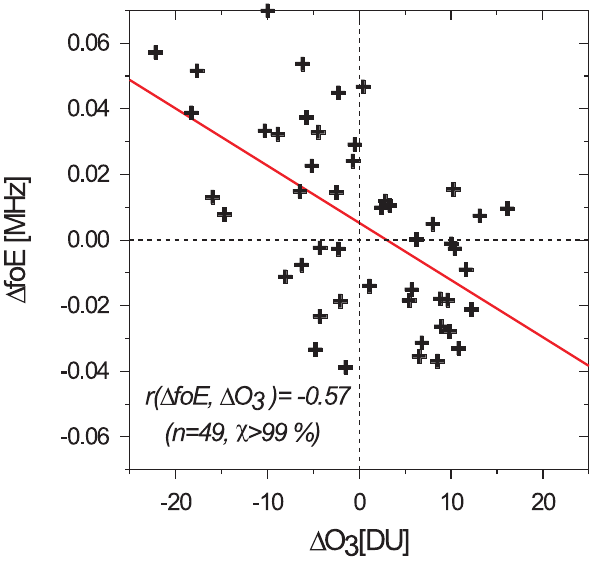
Fig. 13. Correlation between 49 yearly mean values of 1 foE de- duced from ionosonde observations at mid-latitudes and 1 O 3 at Arosa. Table 1. Mean global trends in different ionospheric parameters. N is the number of ionosonde stations used in the trend analyses.